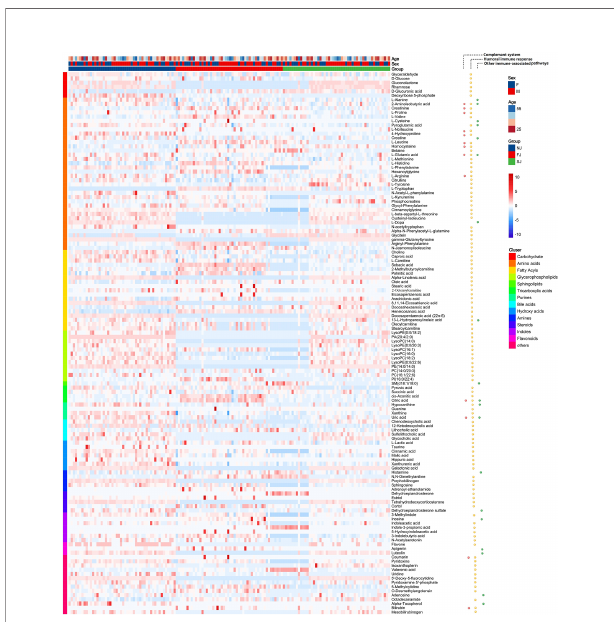
FIGURE 4 | Enrichment and Distribution of Immune Related Metabolites. Heatmap of the DEMs associated with three enriched pathways: complement system, humoral immune response, and other immune associated-pathways.